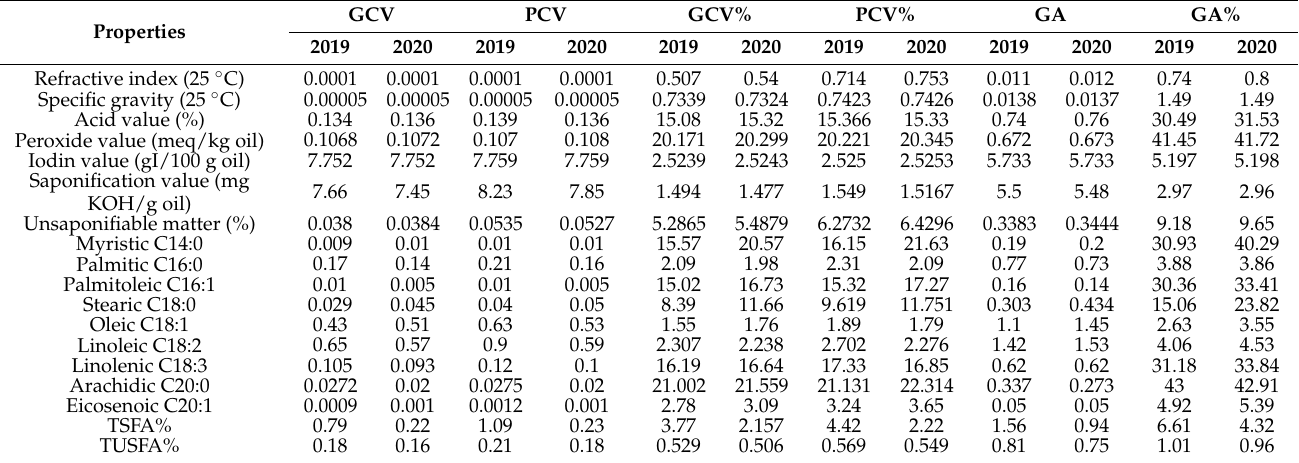
Table 11. Estimates of variability parameters for some physical, chemical properties and fatty acids profile of crude rice bran oil from some rice genotypes (dry weight basis) of the studied genotypes during the 2019 and 2020 growing